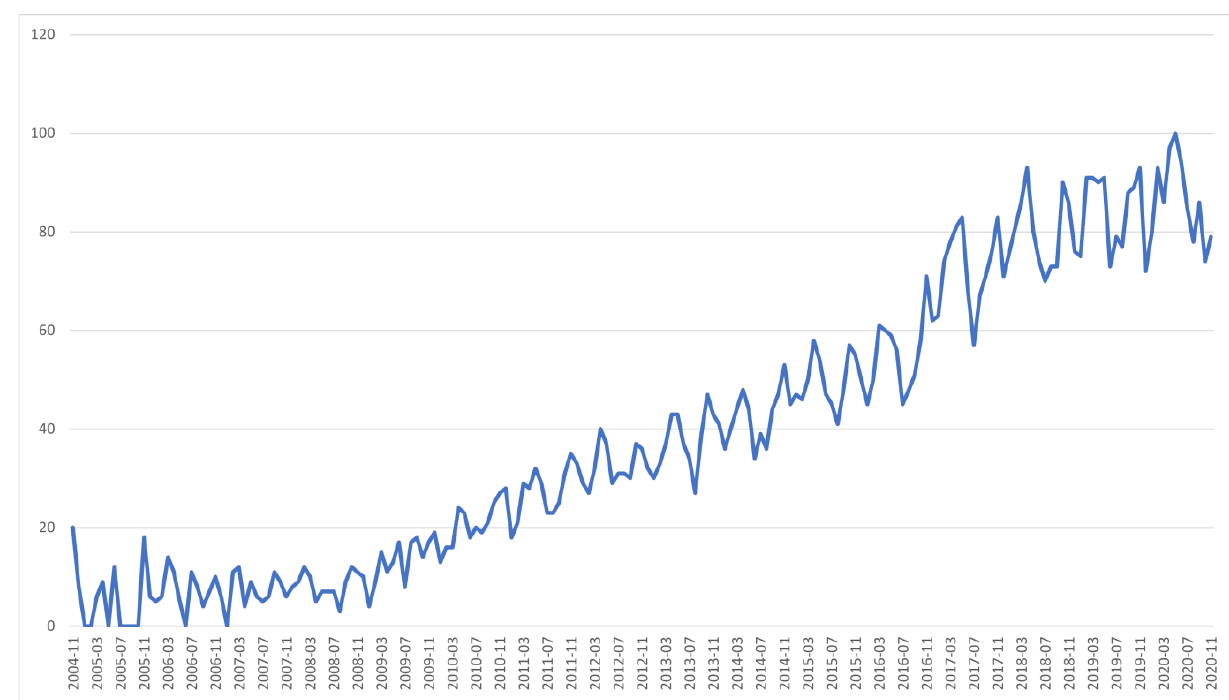
Figure 7. Trends in the interest towards sentiment analysis from 2004 till 2020.